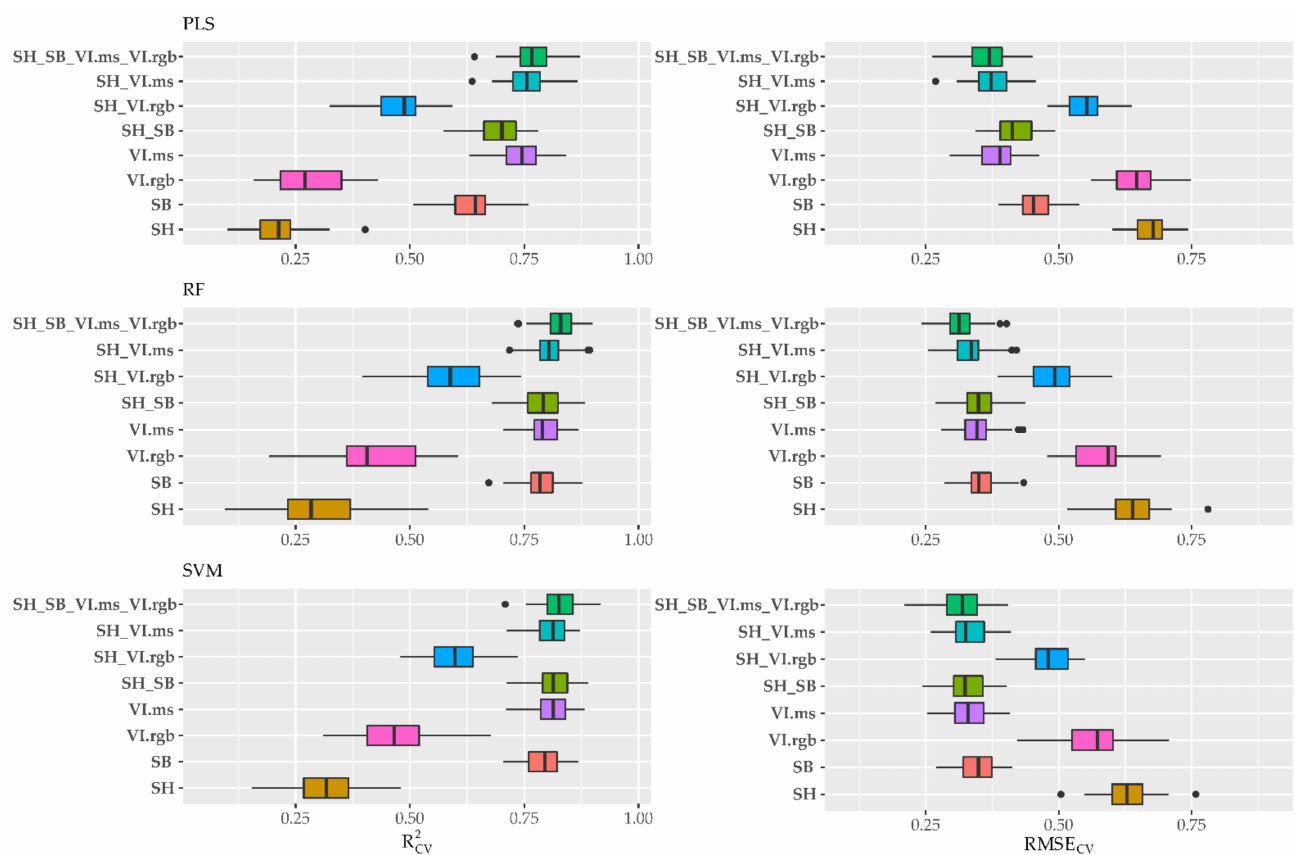
Figure 15. Box and whisker plot of R 2 CV and RMSE CV (%) of all resamples of RF, SVM, and PLS mod- els for N-concentration prediction (SH: sward height metrics. SB: single bands, VI.rgb: RGB-indices, VI.ms: VNIR